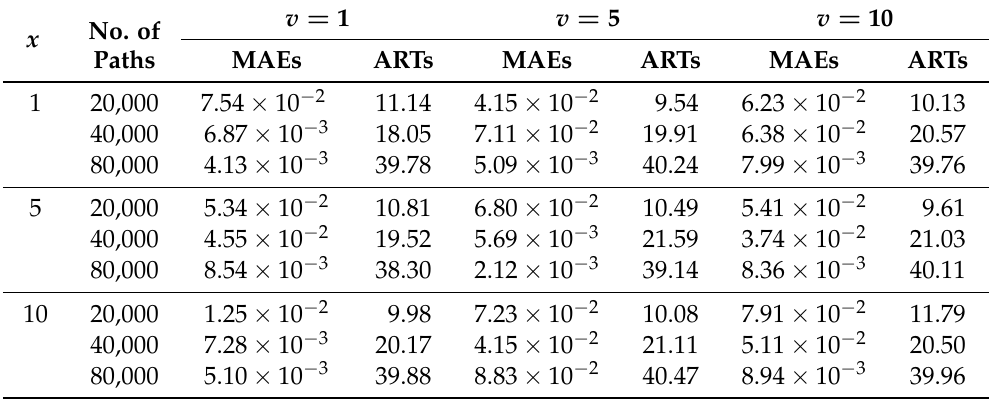
Table 2. MAEs of the second conditional moment u ( 2 ) ( x , v ,1 ) between our formula and the MC simulations together with the average runtimes of the MC